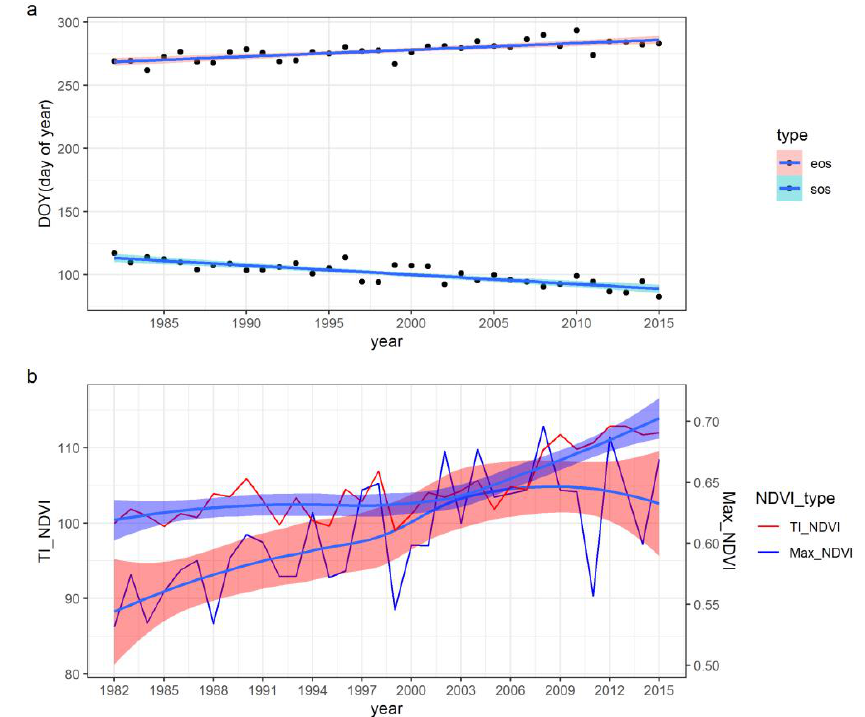
Figure 5. The annual metrics of vegetation phenology ( a ) and the season (max NDVI and time integrated NDVI) time series ( b ) (“sos” denotes start of season, “eos” denotes end of season, “Max_NDVI” represents max NDVI, “TI_NDVI” represents time integrated NDVI).